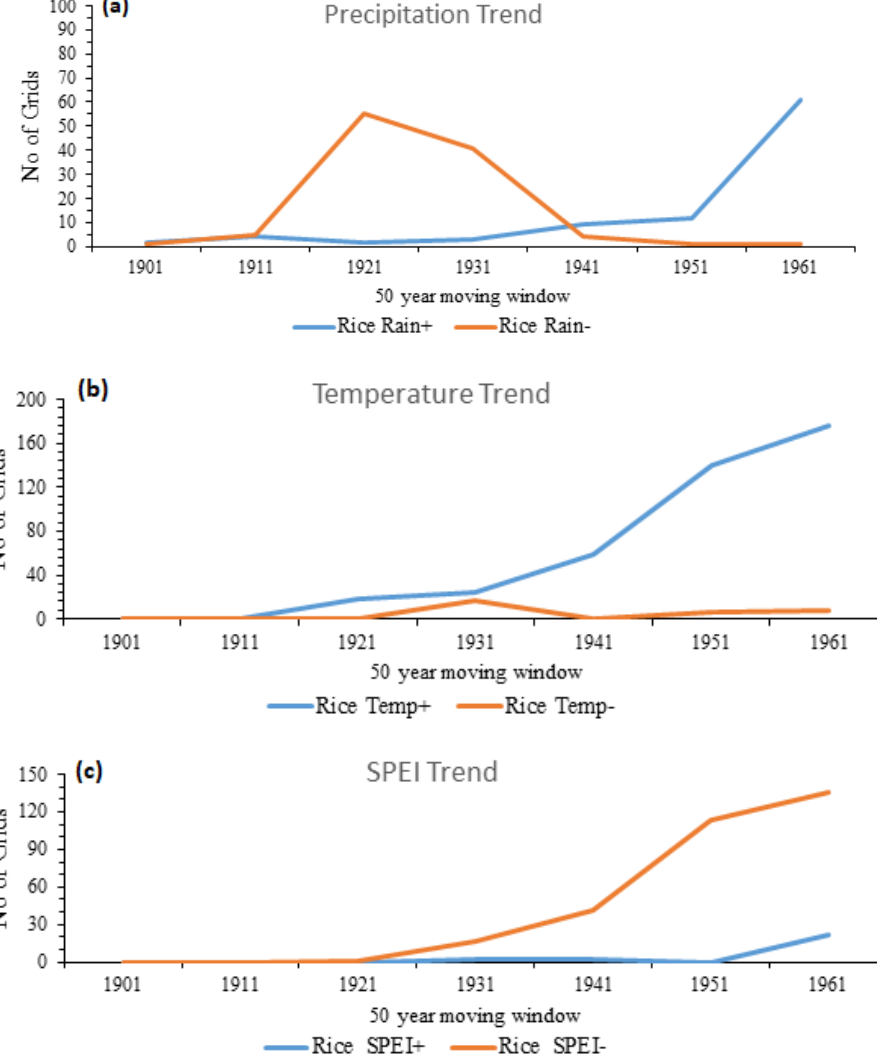
Figure 7. Trends in ( a ) precipitation, ( b ) mean temperature, and ( c ) SPEI during rice-growing period in Afghanistan during 1901–2010.